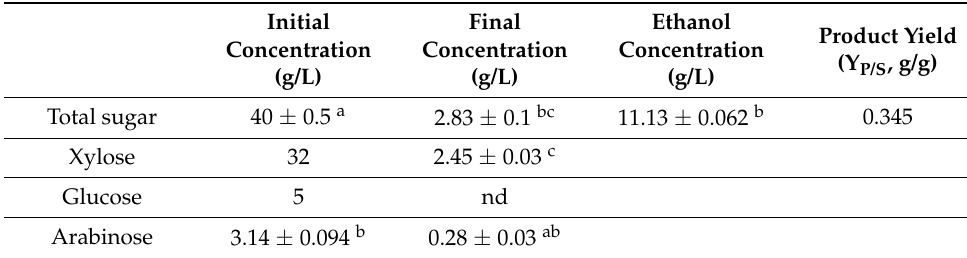
Table 5. Concentration of individual sugars in ethanol production using M. guilliermondii H1 at